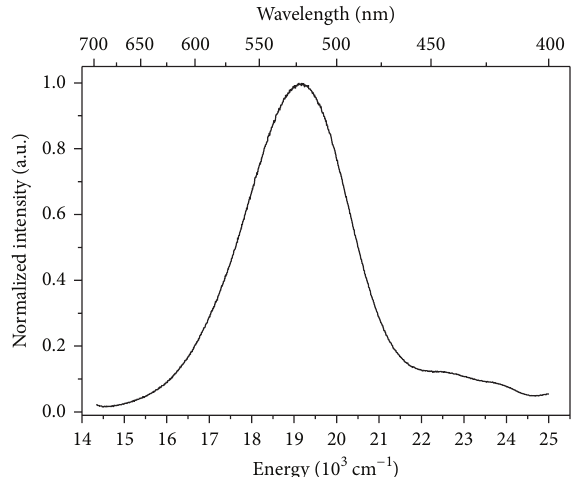
= 27 620 cm −1 ) recorded at ex